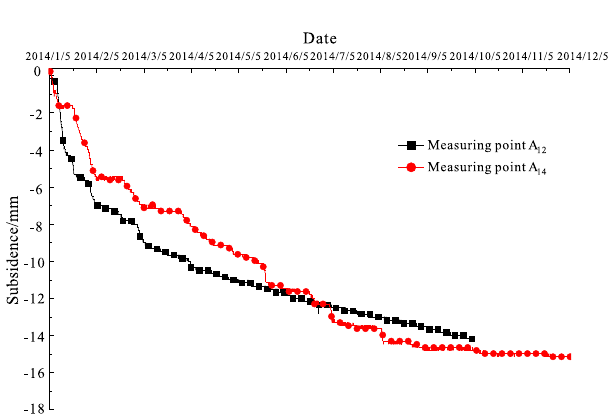
Figure 16. Curves of surface subsidence measurements against